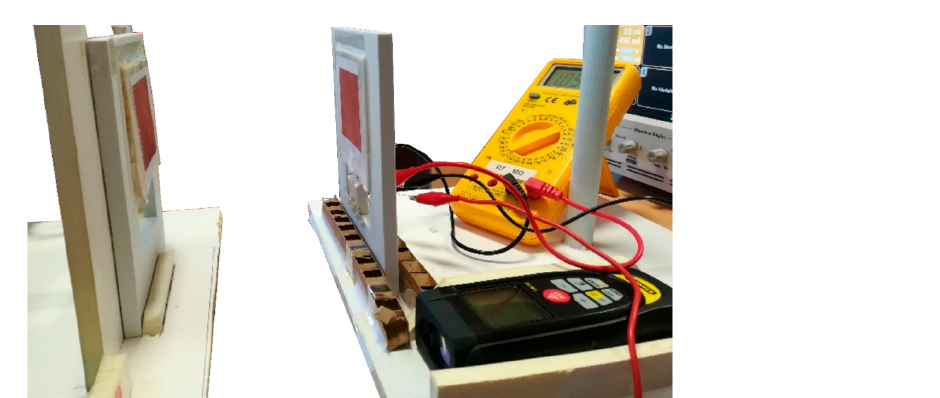
Figure 13. Single rectenna PCE measurement setup.